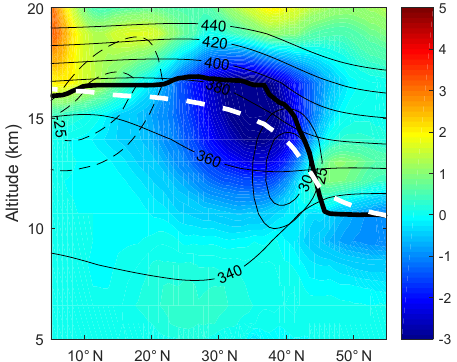
Figure 7. Number of MIPAS aerosol detections between 40 and 120 ◦ E during June–August 2009 (binned every 2km in altitude and 2 ◦ in latitude). Sparse detections (number of detections in each bin is smaller than 10) are shown with black dots. The tropopause, po- tential temperature, and zonal wind are the same as shown in Fig.